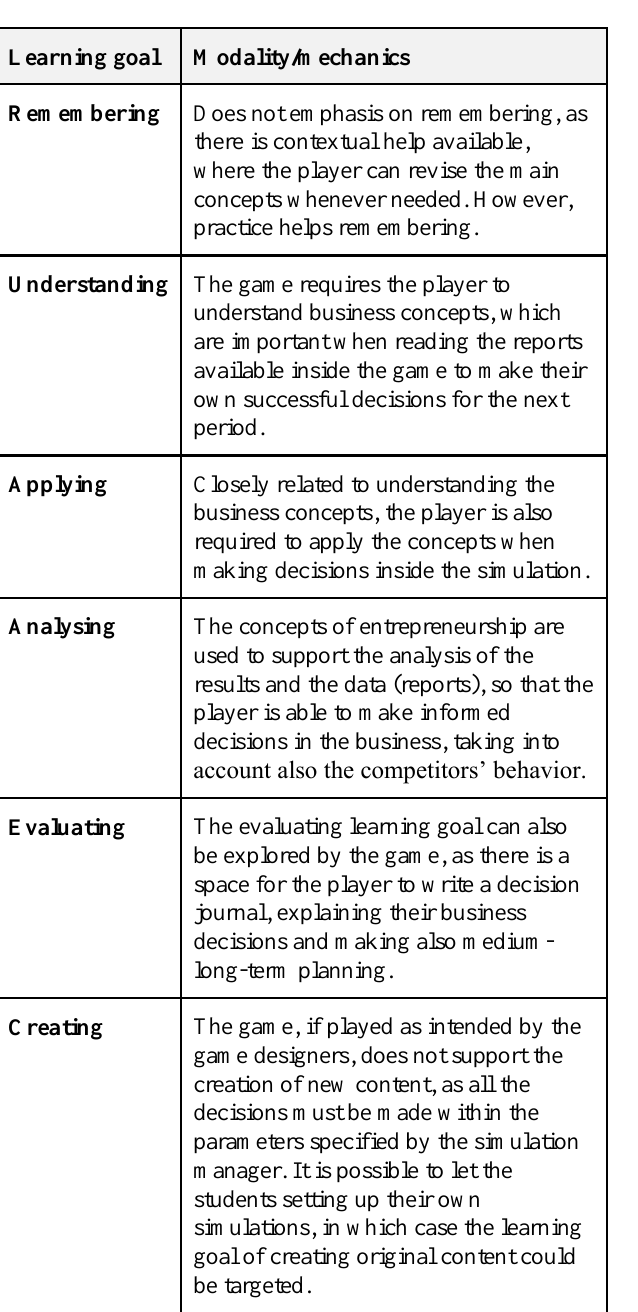
Table 4: Bloom’s cognitive learning goals covered